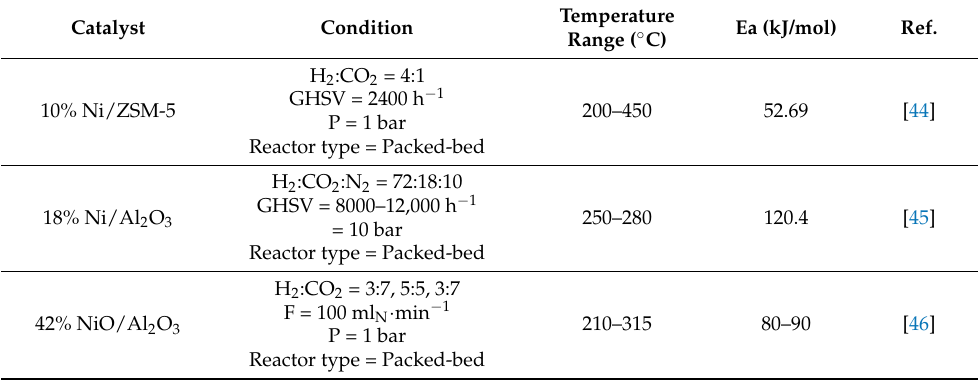
Figure 8. Arrhenius plot for estimated kinetic parameters for CO 2 methanation on 40 wt% Ni- CeO 2 /Cr 2 O 3 catalyst. Table 2. Summary of activation energy from previous reported study.